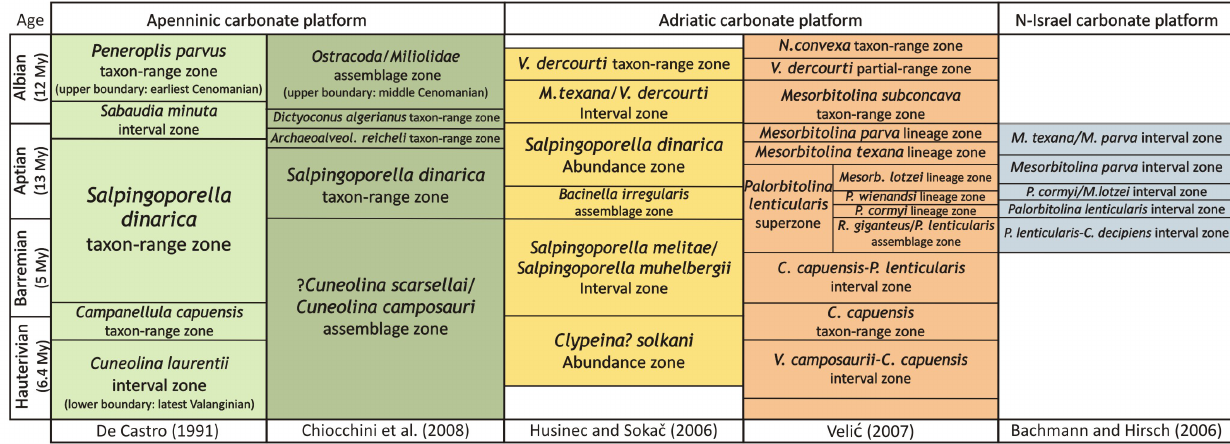
Fig. 1. Barremian-Aptian biostratigraphy of central-southern Tethyan carbonate platforms. These schemes suffer of low resolution and poorly constrained chronostratigraphic